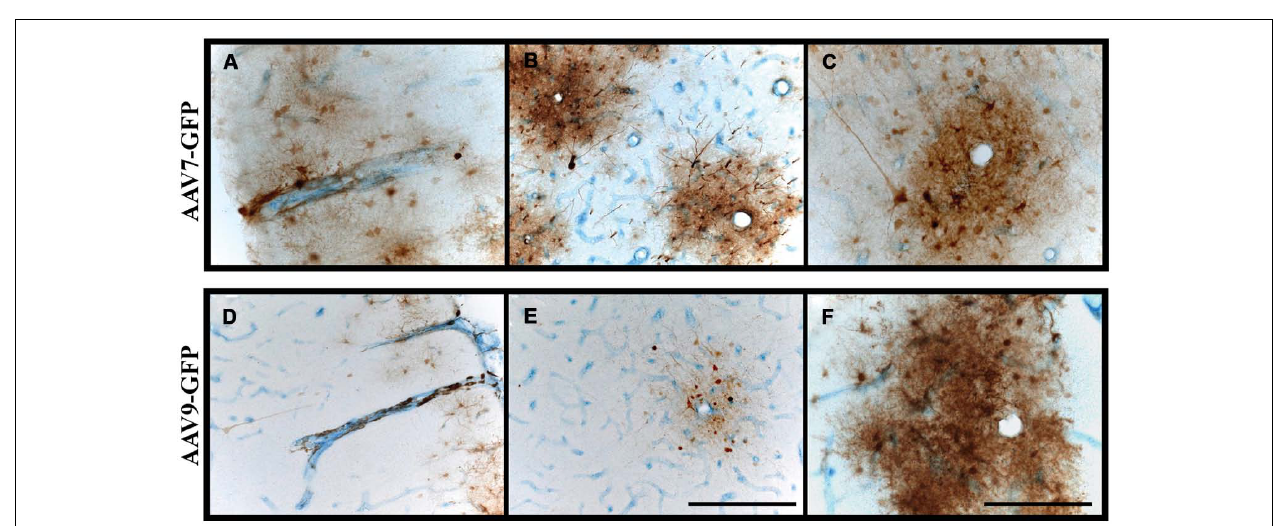
FIGURE 5 | Perivascular transport and pattern of transgene expression. (A–F) Immunostaining against GFP and blood vessels (CD31; endothelial marker) revealed the presence of GFP-positive cells surrounding blood vessels. Transgene expression was frequently